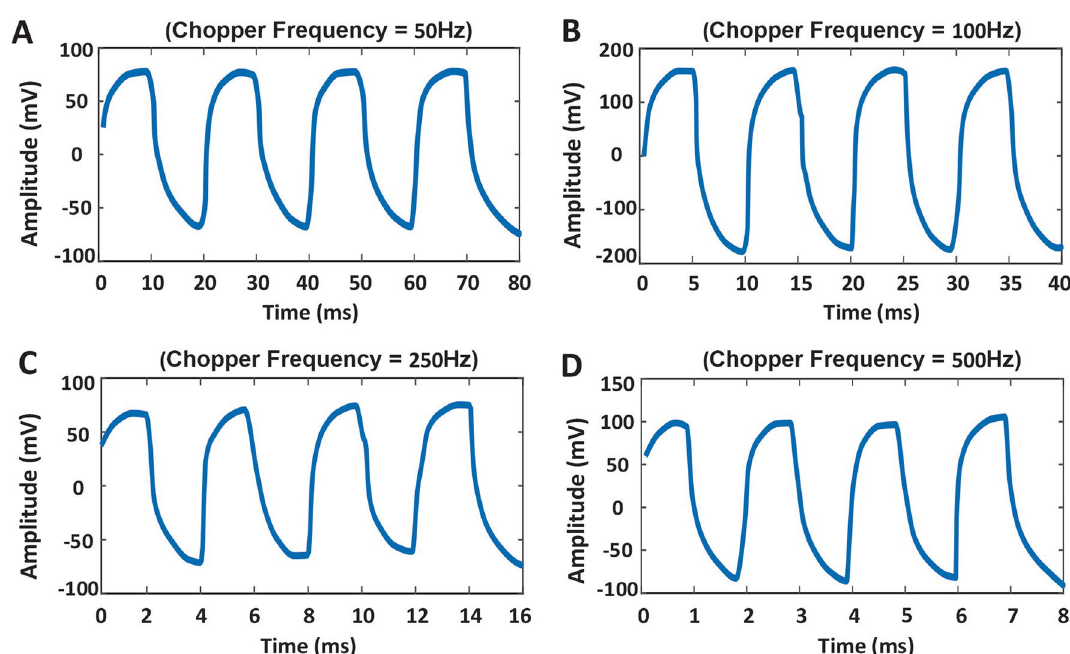
Figure 8. Response time of the fabricated IR camera measured practically. Response time for frequencies: ( A ) f = 50 Hz, rise time = 3.03 ms, ( B ) f = 100 Hz, rise time = 1.98 ms, ( C ) f = 250 Hz, rise time = 0.73 ms and ( D ) f = 500 Hz, rise time = 0.363